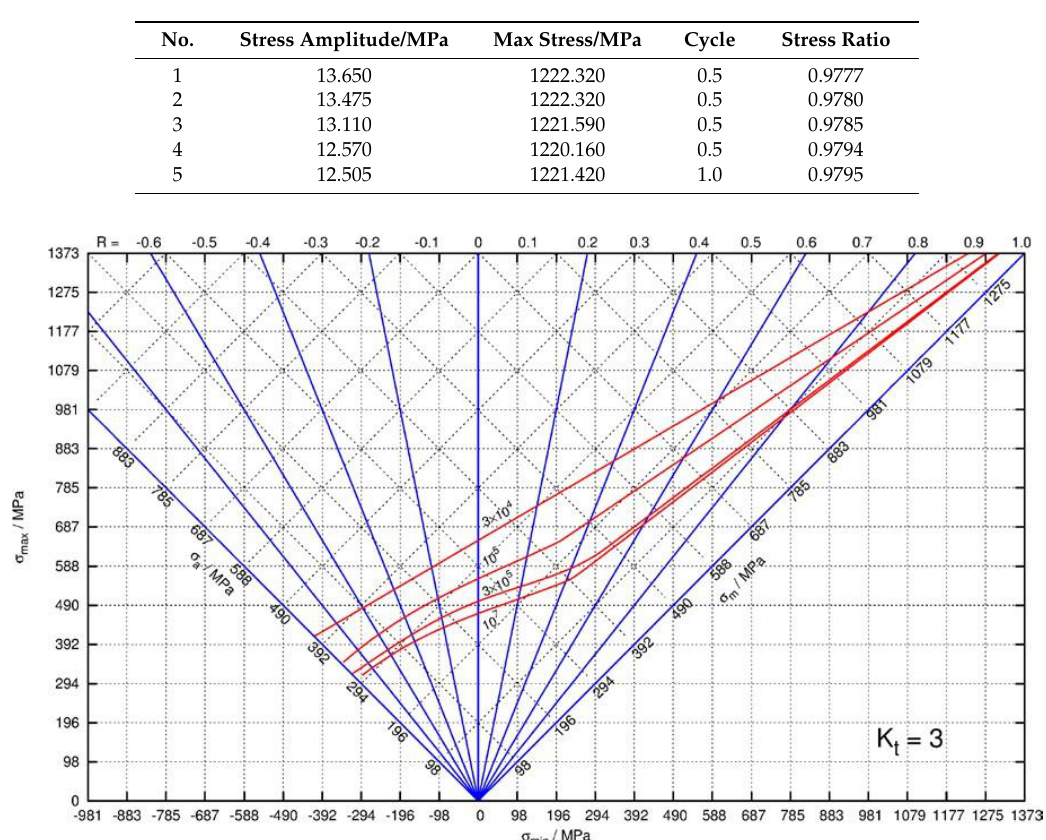
Table 4. Rainflow counting results of Tresca stress.